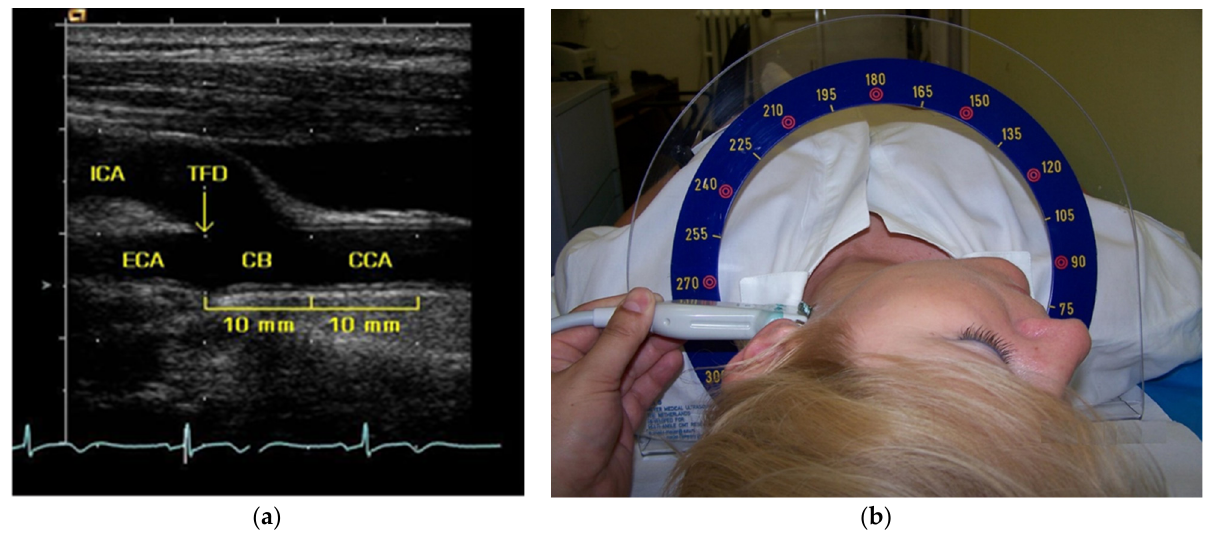
Figure 1. ( a ) Longitudinal B-mode image of the carotid artery showing clear interfaces for measure- ment of intima-media thickness at the far wall of the common carotid artery and carotid bifurcation. CB, carotid bifurcation; CCA, common carotid artery; ECA, external carotid artery; ICA, internal carotid artery; TFD, tip of the flow divider. ( b ) The Meijer´s Arc allows a standardized scan of the left and right carotid artery in predefined angles.